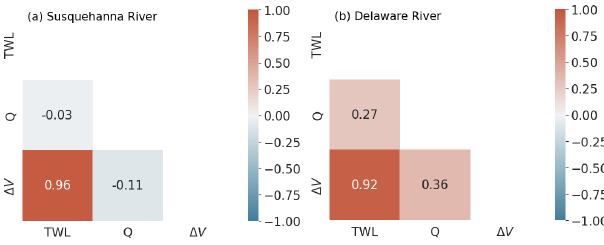
Figure 9. The correlation coefficient ( r ) matrix of (cid:49)V , Q and TWL in the Susquehanna River (a) and Delaware River (b)